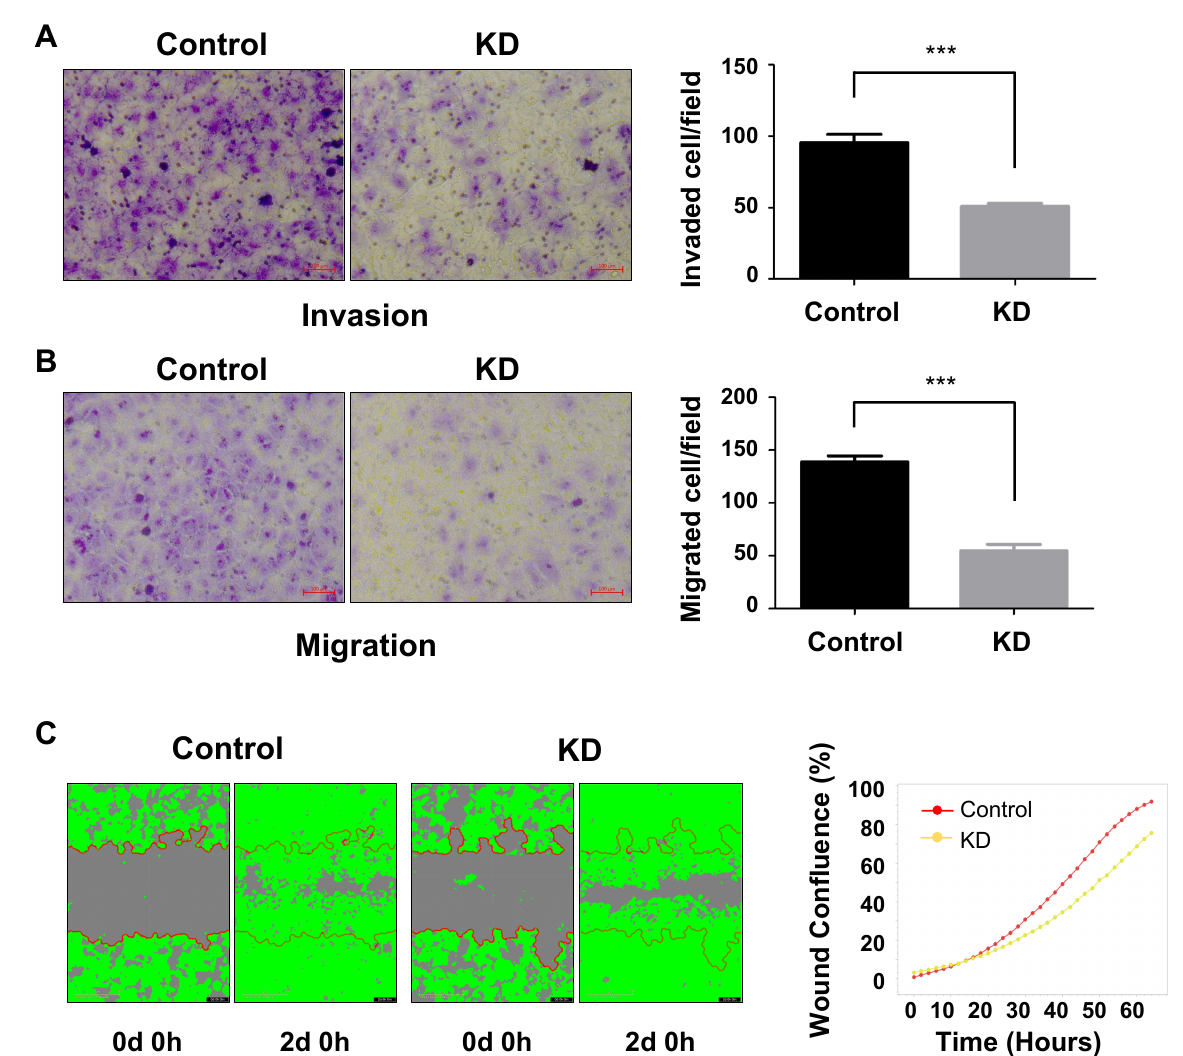
Figure 4. Downregulation of PLEKHA8P1 inhibits migration and invasion of HCC cells. ( A , B ) Transwell assays were performed to determine invasive ( A ) and migratory ( B ) properties of cancer cells. Representative images of six random fields per well are shown ( × 200 magnification). Scale bars represent 100 µ m. ( C ) Wound-healing assays were conducted for up to 3 days. Representative images of each group at specific time-points are presented. All data were acquired from three independent experiments and p -values were determined by two-tailed unpaired t -test analysis. *** p <